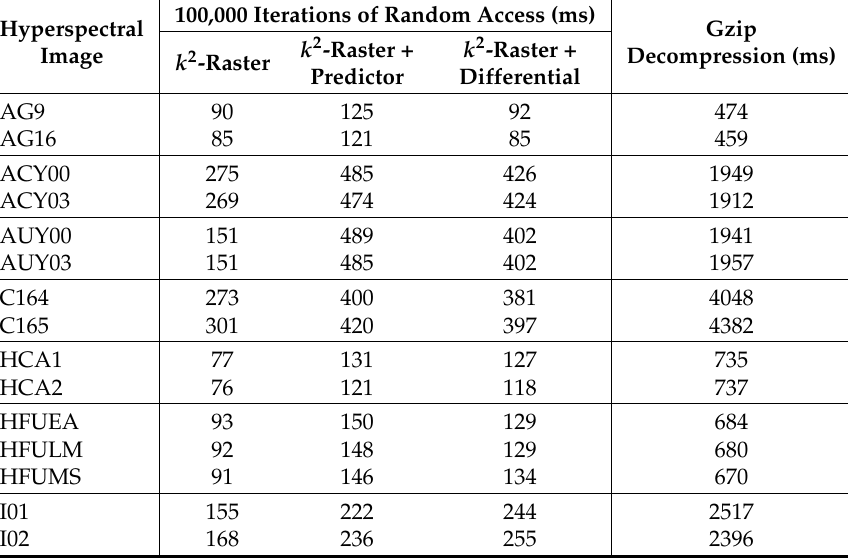
Table 4. A comparison of access time (in milliseconds) using k 2 -raster only and k 2 -raster with predictive and differential